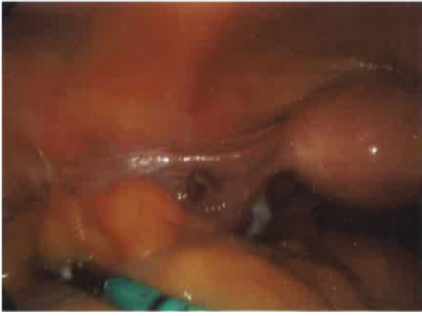
Figure 1: Stone-like material deeply embedded in broad ligament.